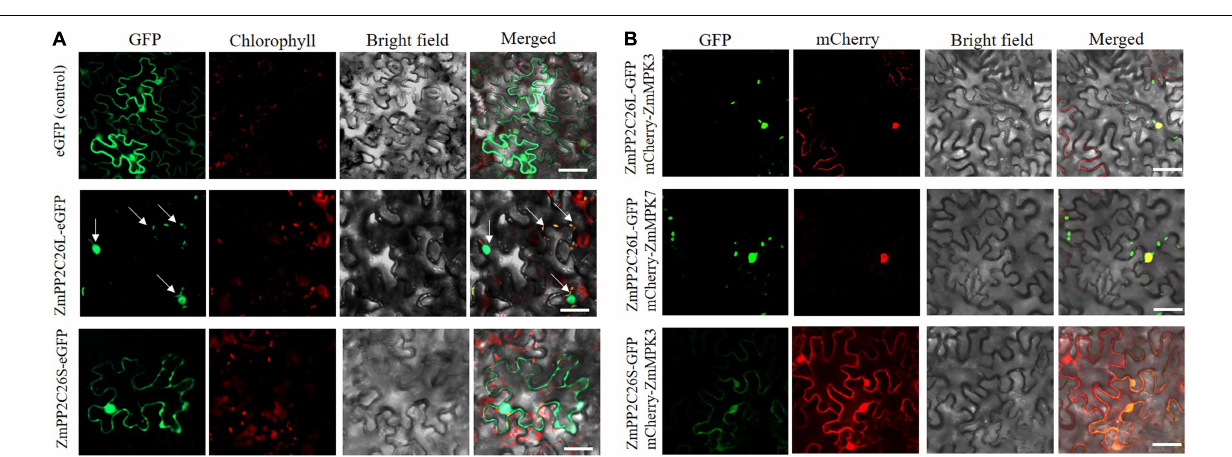
FIGURE 4 | Subcellular localization and co-localization. (A) The localization of ZmPP2C26L and ZmPP2C26S. (B) Co-localization of ZmPP2C26L and ZmMAPK3/ZmMAPK7 and of ZmPP2C26S and ZmMAPK3. ZmPP2C26L and ZmPP2C26S were fused with eGFP . ZmMAPK3 and ZmMAPK7 were separately fused with mCherry. A 4-week-old tobacco ( Nicotiana benthamiana ) seedling was used for infiltrating using Agro . Tumefaciens cells harboring above plasmids. Scale bar = 50 µ